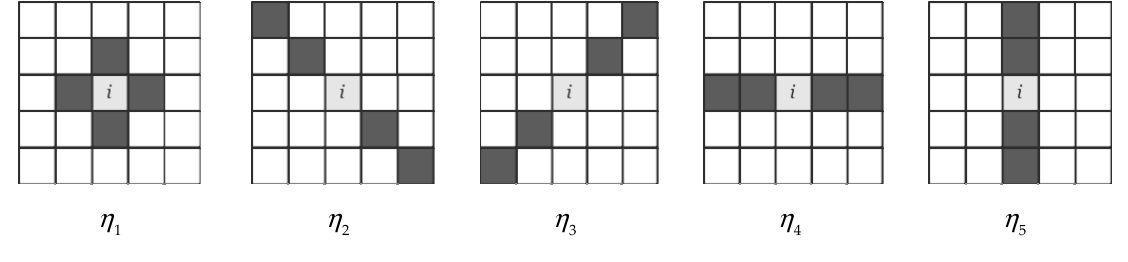
Figure 2. Five candidates of the adaptive neighborhood.